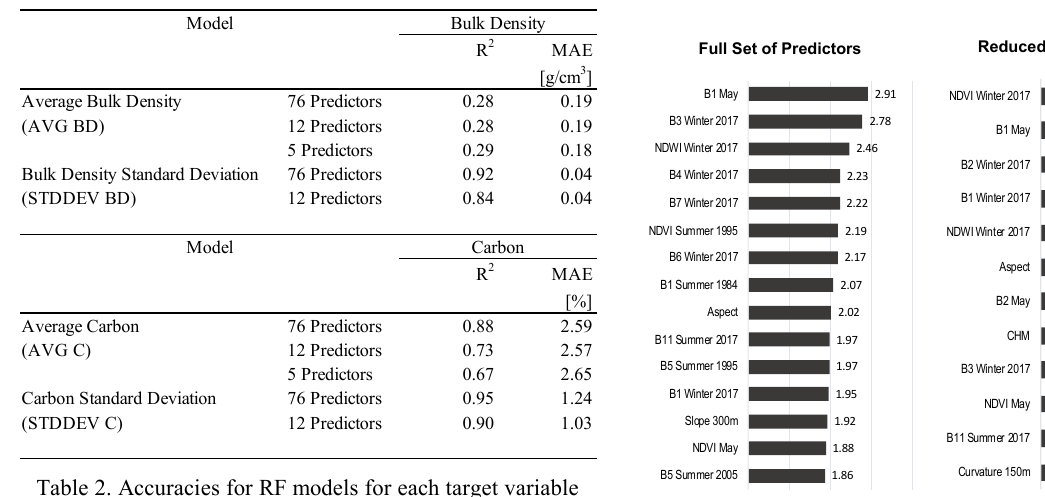
Figure 2. Variable importance of the predictors for the RF models for AVG BD for the 0-15 cm depth layer.